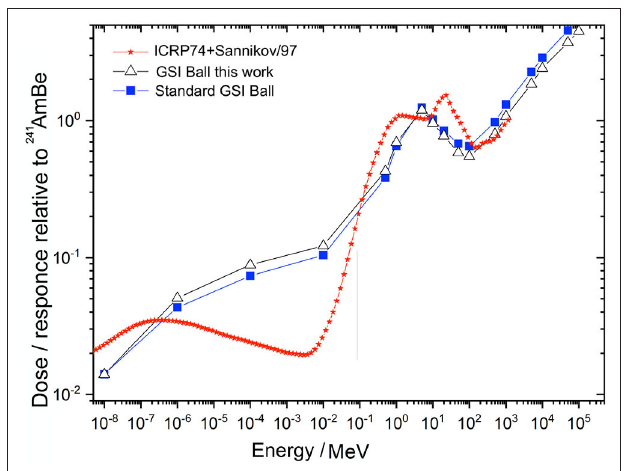
FIGURE 1 | Calculated neutron fluence response of the standard GSI ball (scatter-line with solid blue squares) and the new GSI ball holding three TLD cards (scatter-line with black open triangles) and the fluence-to-dose conversion function for ambient dose equivalent H *(10) [ 24, 25] (red stars).